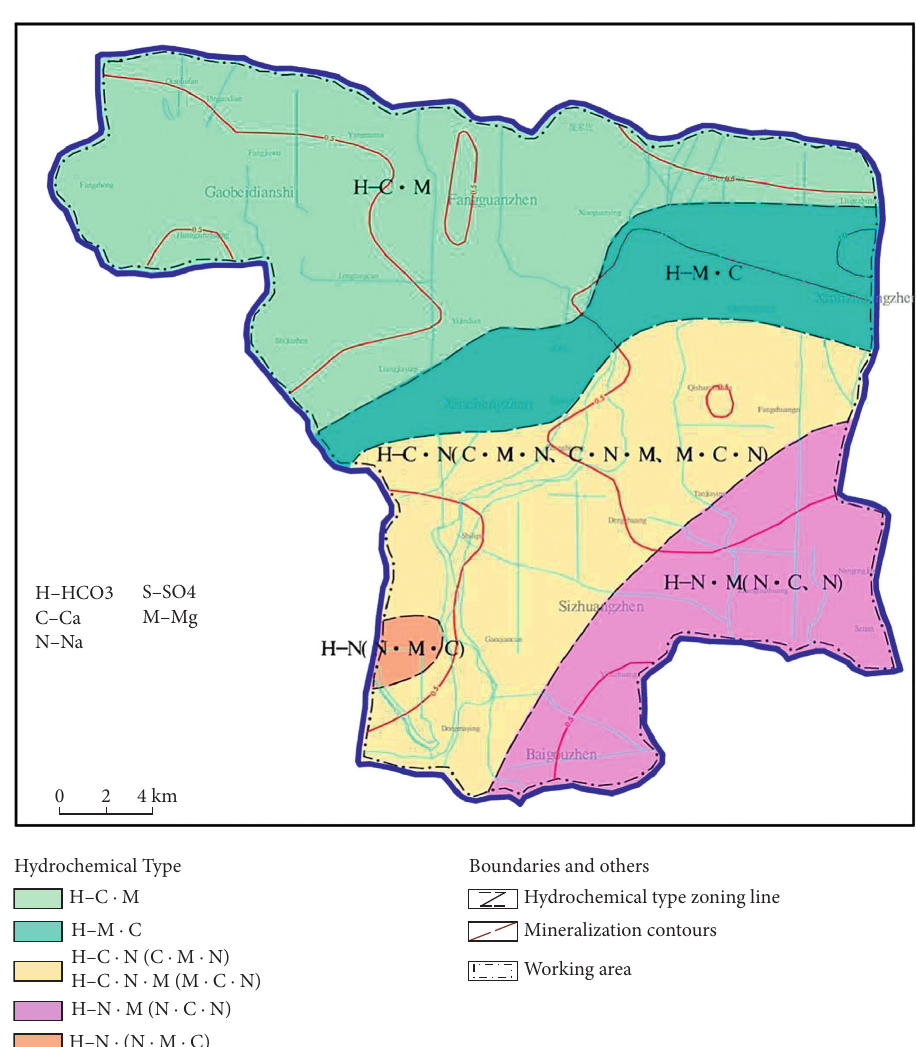
Figure 3: Spatial variation in groundwater hydrochemical type of the shallow groundwater.